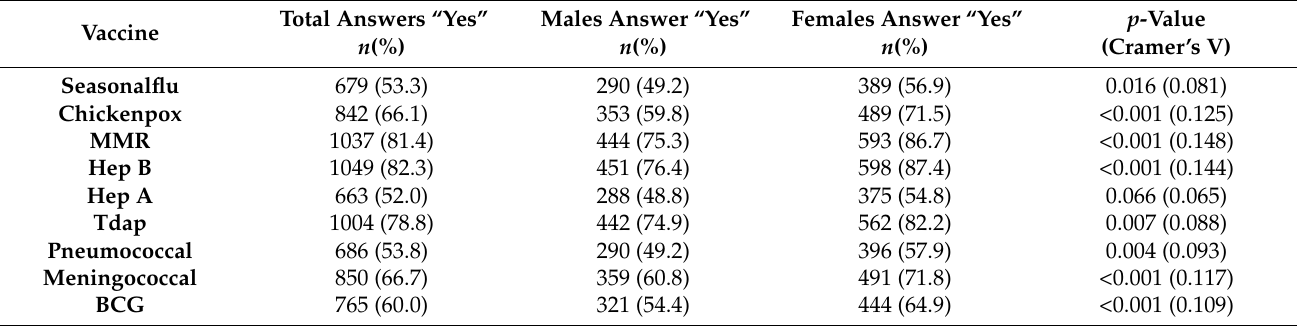
Table 3. Knowledge distribution by